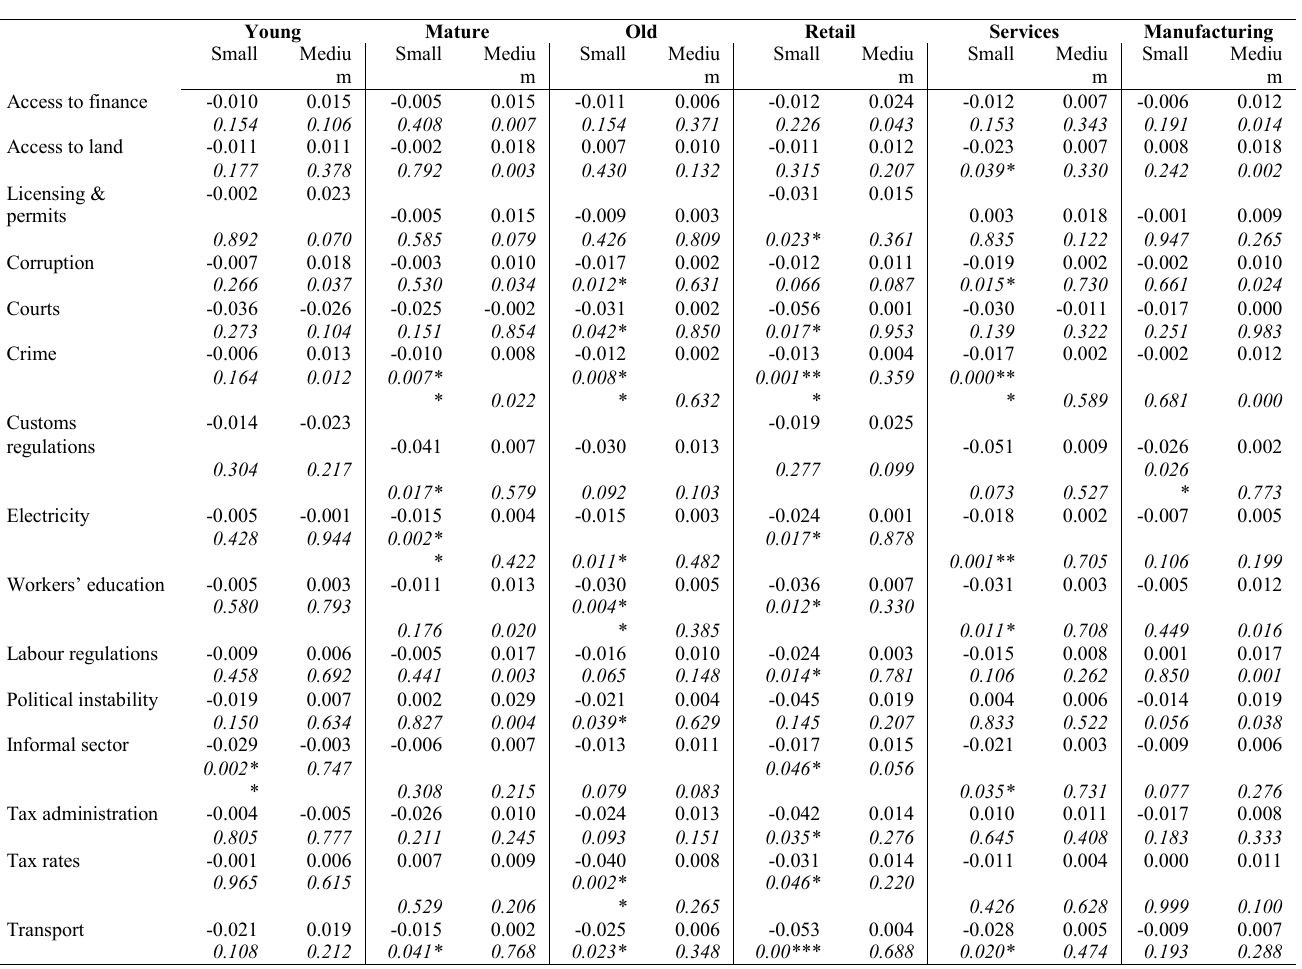
Table 6: Interaction for each obstacle